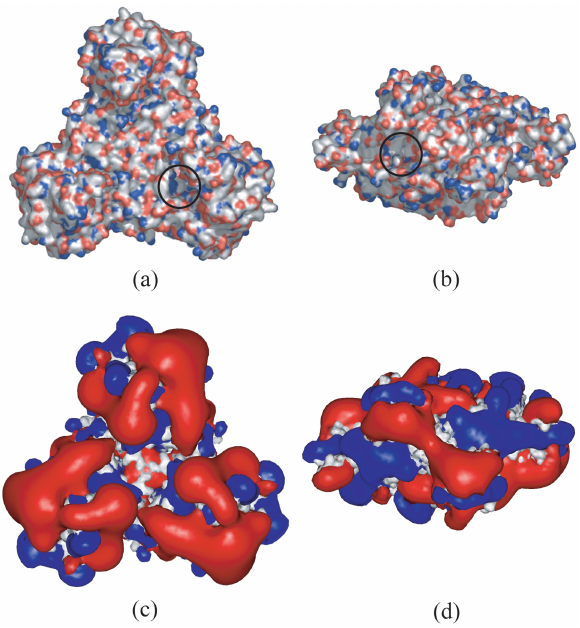
Figure 5. (a) The ornithine carbamoyltransferase (OTC) catalytic trimerand (b) the carbamatekinase(CK) dimer. Blue areason the mo- lecular surface represent electrostatically positive regions and red ar- eas electrostatically negative regions. Circles indicate one of the CP binding sites of OTC (a) and CK (b). Electrostatic isopotential con- tours around the OTC trimer (c) and CK dimer (d), viewed from the same position as in (a) and (b). The blue surface connects all points having a potential of +1.0 kT. The red surface connects all points hav- ing a potential of –1.0 kT. Electrostatic potentials were calculated and displayed with the DelPhi